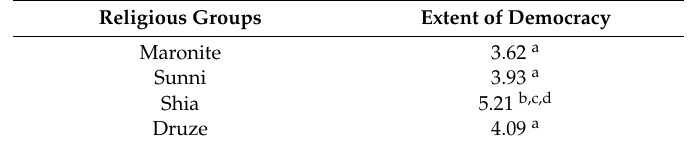
Table 4. Religious Group Mean Evaluations of the State of Democracy in Lebanon.